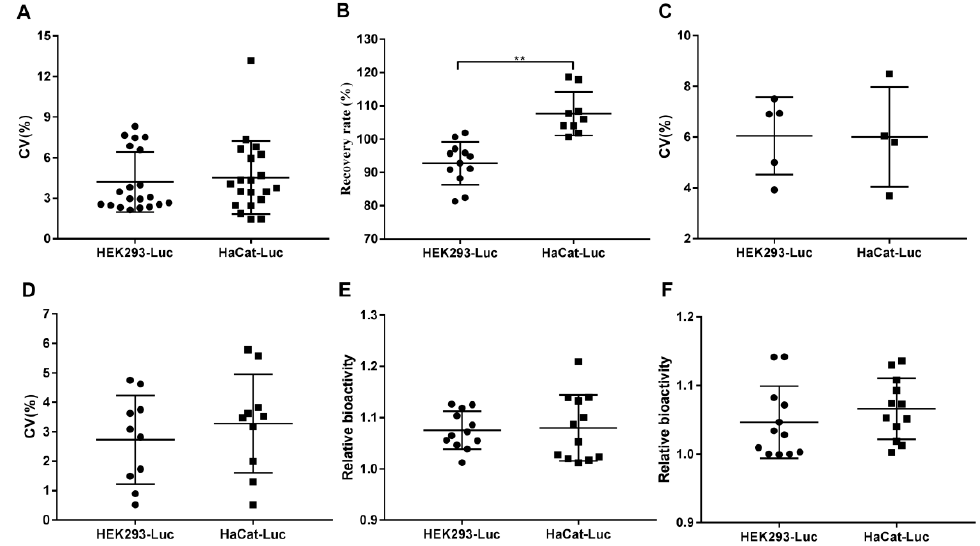
Figure 6. Comparison of validation between the HEK293-Luc and HaCat-Luc cell lines responding to rhKGF-1. Validation of bioactivity procedures is depicted in detail in the Results section. ( A ) CV of linearity validation (n = 20). ( B ) Recovery rate (n = 12 for the HEK293-Luc cell line and n = 9 for the HaCat-Luc cell line), p = 0.0057. ( C ) CV of accuracy validation (n = 5 for the HEK293-Luc cell line and n = 4 for the HaCat-Luc cell line). ( D ) CV of precision validation (n = 10). ( E ) Relative bioactivity of the final rhKGF-1 product (n = 12). ( F ) Relative bioactivity of bulk rhKGF-1 (n = 12). The mean ± SD